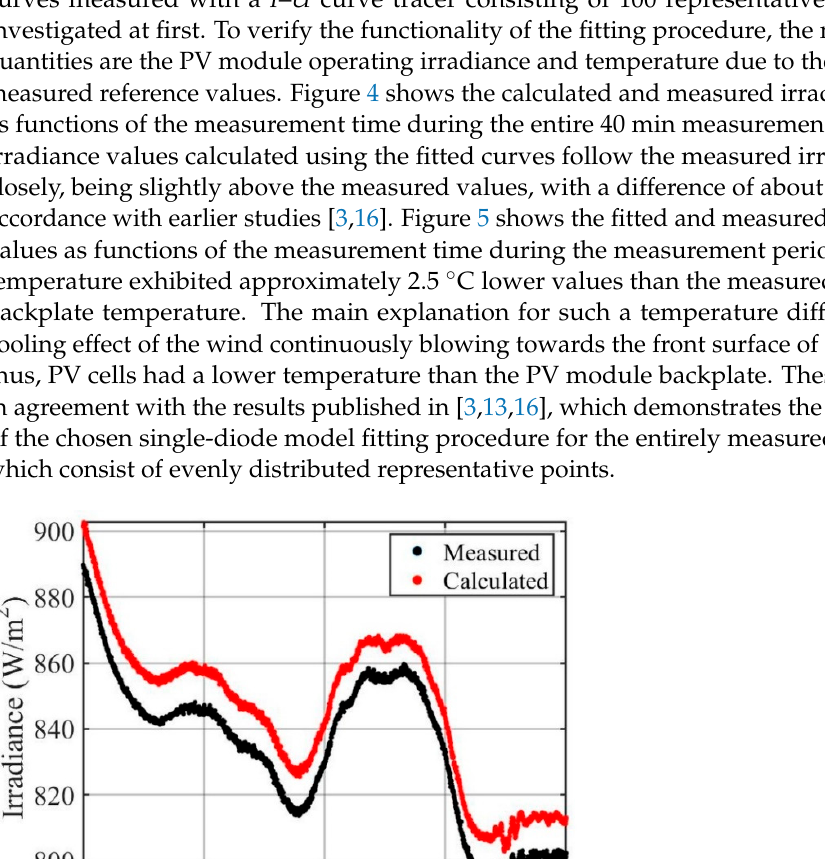
Figure 3. Measured I – U curve (green) jointly with cutting limits of 35% of U MPP on the left (red) and on the right (black) side of the MPP.